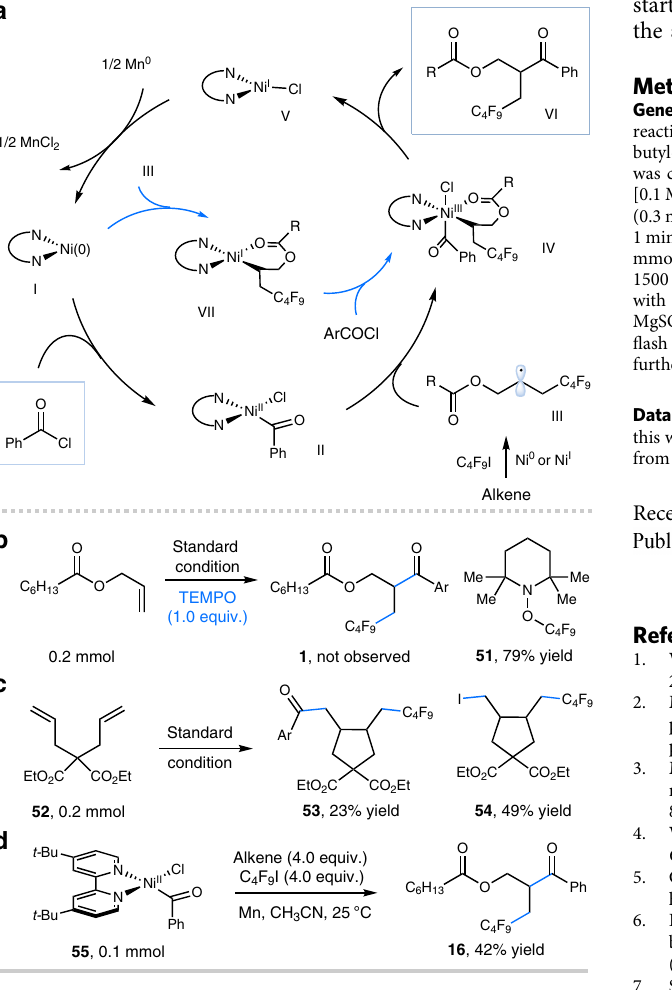
Fig. 5 Mechanistic studies. a Proposed mechanism. b Radical inhibition experiment. c Radical clock experiment. d Stoichiometric reaction of isolated Ni(II) complex. See Supplementary Discussion. Ar = 4- tert - butylphenyl. alkene = allyl